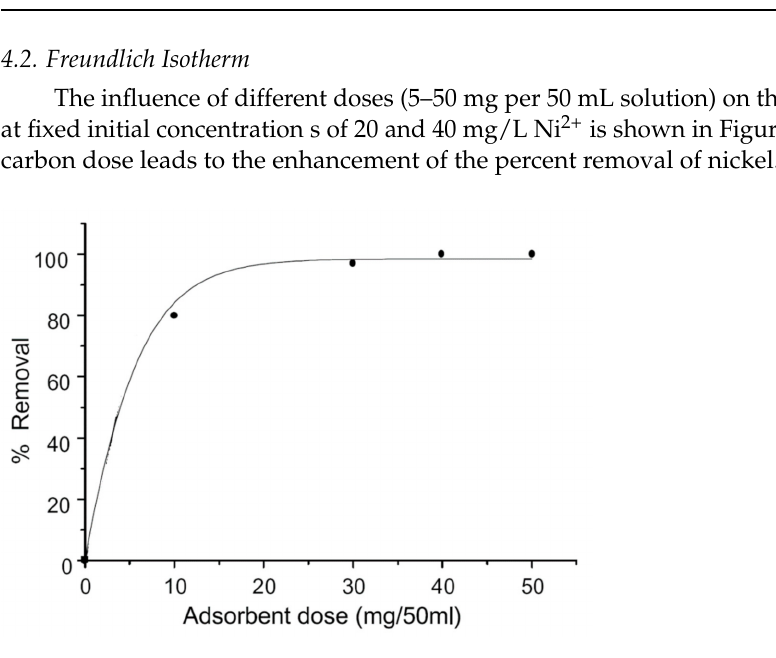
Figure 8. Effect of carbon dosage on the removal of Ni (II)/pH 2, time of treatment 1 h/. The linear form of Freundlich equation log( x /m) = lg K f + lgC e /n is applied to